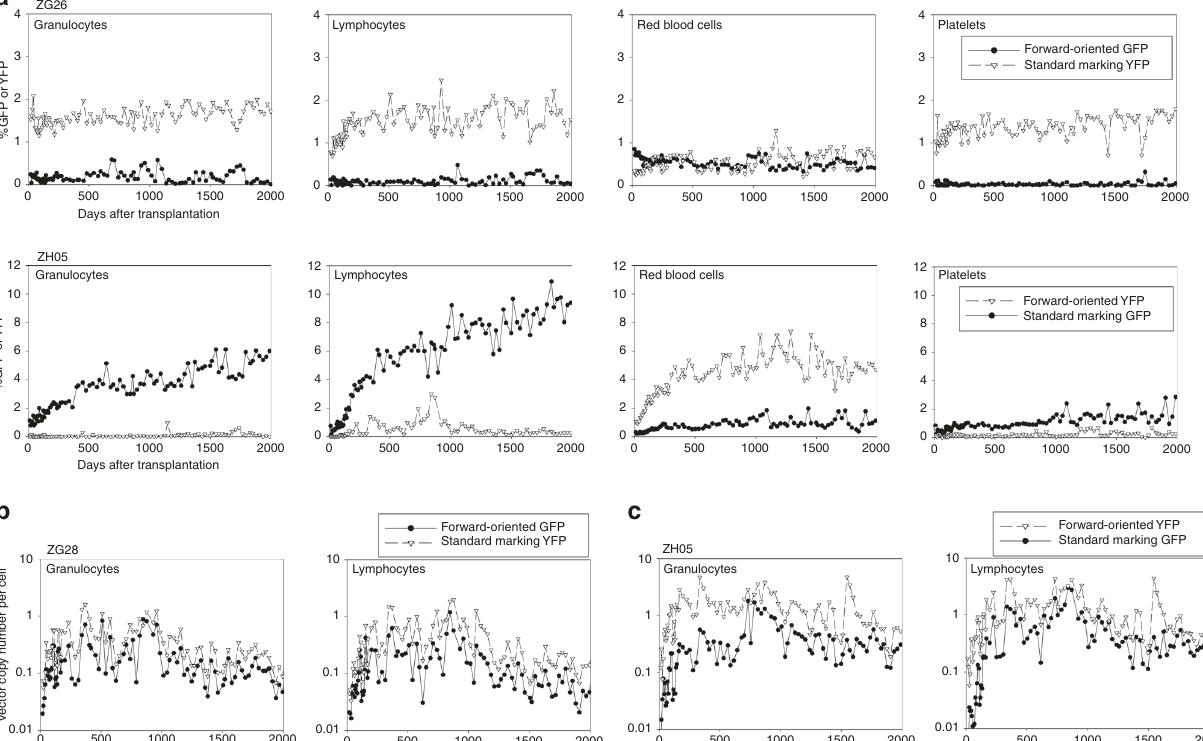
Fig. 3 The forward-oriented vector achieves long-term marking levels in long-term hematopoietic repopulating cells in rhesus macaques similar to a standard gene marking vector. a – c We compared the forward-oriented vector with a standard gene marking vector including a GFP or YFP gene in the rhesus competitive repopulation assay. In two animals (ZG26 and ZH05), GFP and YFP gene-marking levels with the forward-oriented vector were evaluated by GFP- or YFP-positive percentages ( a ) and VCNs ( b , c ) for 5 years, as compared with a standard GFP or YFP-marking